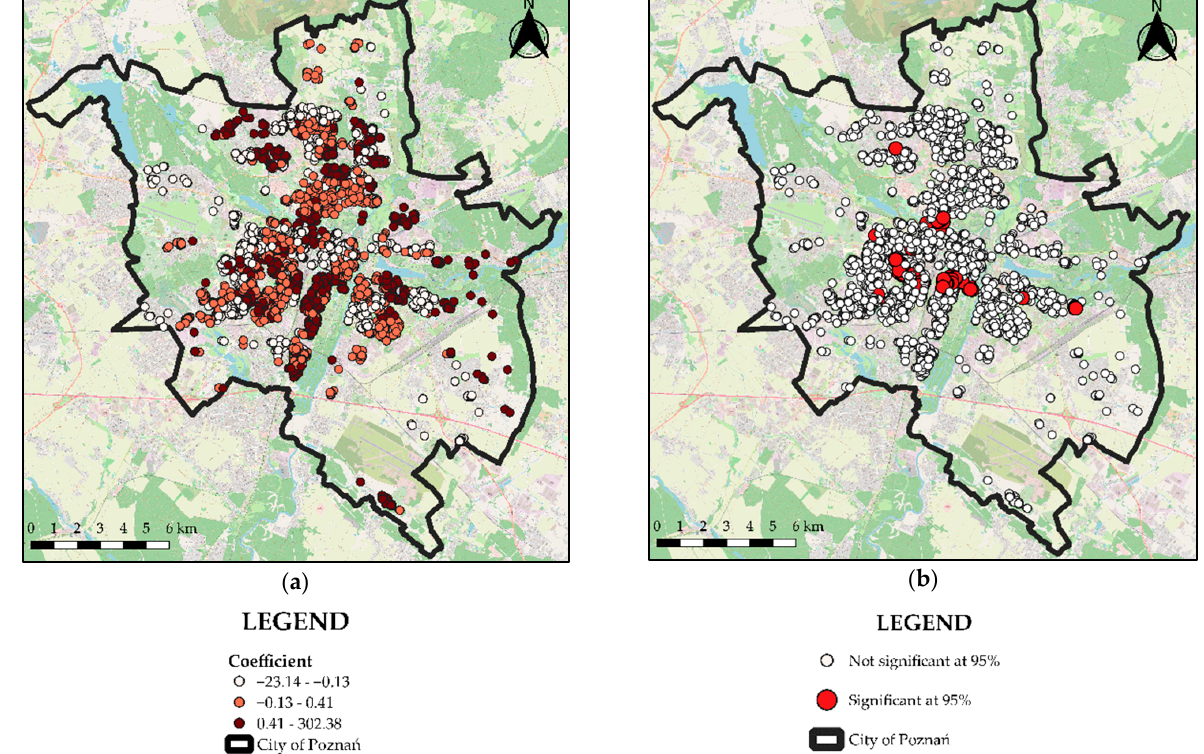
Figure 7. ( a ) Local estimated coefficients—DT. ( b ) Statistical significance of estimated coefficients—DT.